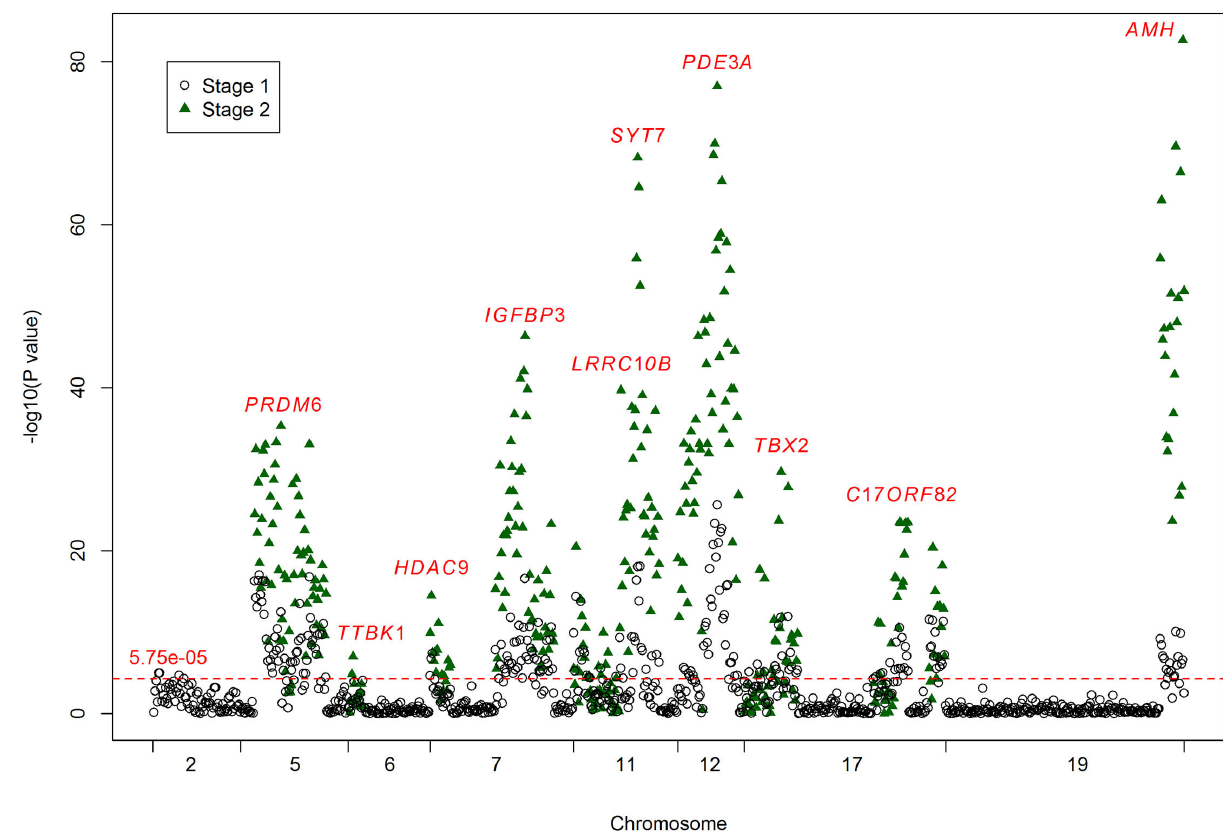
FIGURE 1 | Results for the associations between DNA methylation and ischemic stroke. The crude P -values for the associations between DNA methylation and ischemic stroke. The x-axis represents the chromosome positions. The y-axis shows the –log 10 P -values for the associations between the levels of DNA methylation sites and ischemic stroke. A total of 866 methylation sites were analyzed in stage one (black circles), and 224 of them passed the significance threshold of 5.75 × 10 − 5 (red line). A total of 377 methylation sites were analyzed in stage two (green triangles), and 296 of them passed the significance threshold of 5.75 × 10 − 5 . The associated methylation sites tend to cluster in